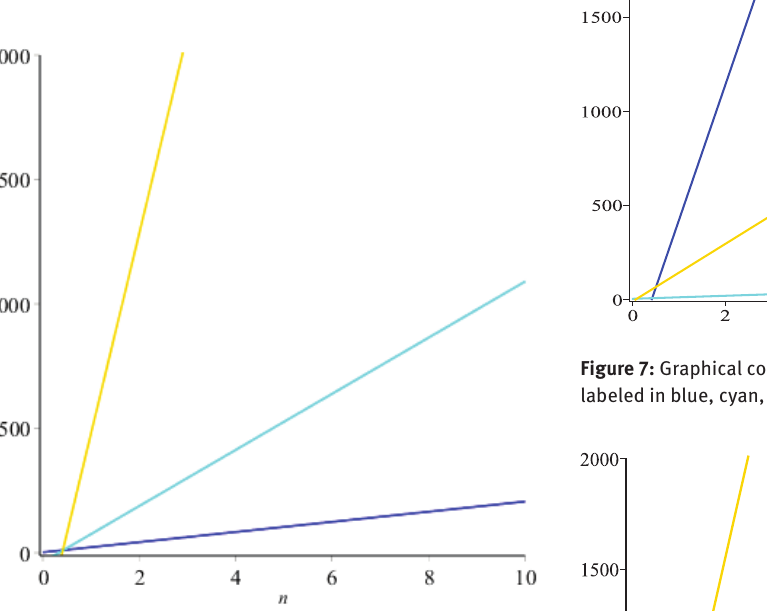
Figure 5: Graphical comparison of H (G), IS (G)), and AZI (G) are labeled in blue, cyan, and gold graphs, respectively, for MON